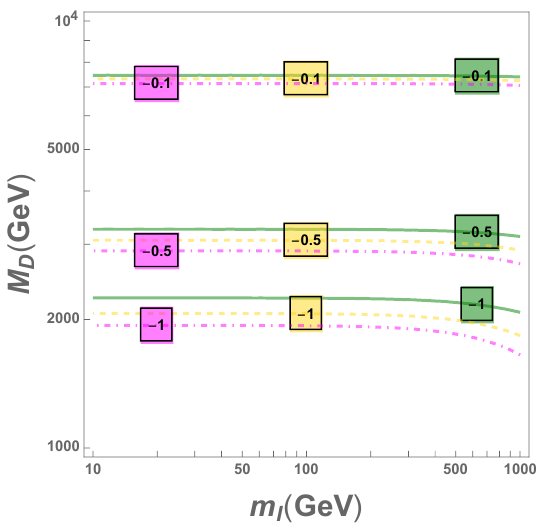
Figure 6 . A contour plot for the combination of Wilson coe(cid:14)cients C 7 (cid:13) +0 : 24 C 8 g with contour lines 0 : 1 ; 0 : 5 ; 1 : 0 in the unit of 10 (cid:0) 4 in the ( m I ; M D )-plane for (cid:21) s (cid:21) (cid:3) (cid:0) (cid:0) (cid:0) of m R . The green solid (yellow dashed, magenta dot-dashed) lines correspond to m R = 1(2 ; 3)